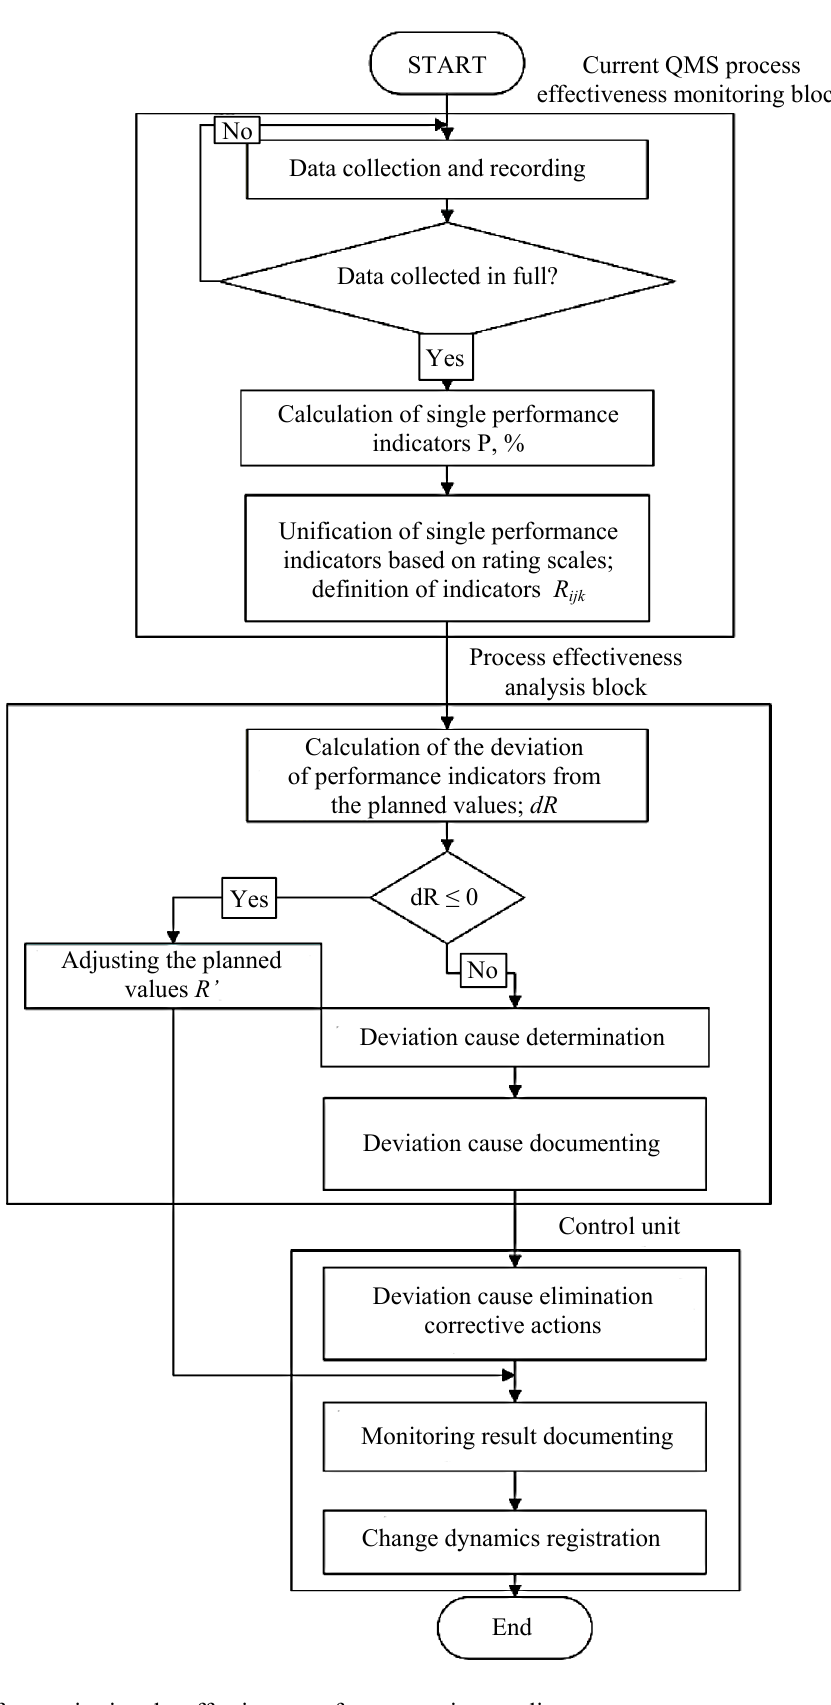
Fig. 5. Algorithm for monitoring the effectiveness of processes in a quality management